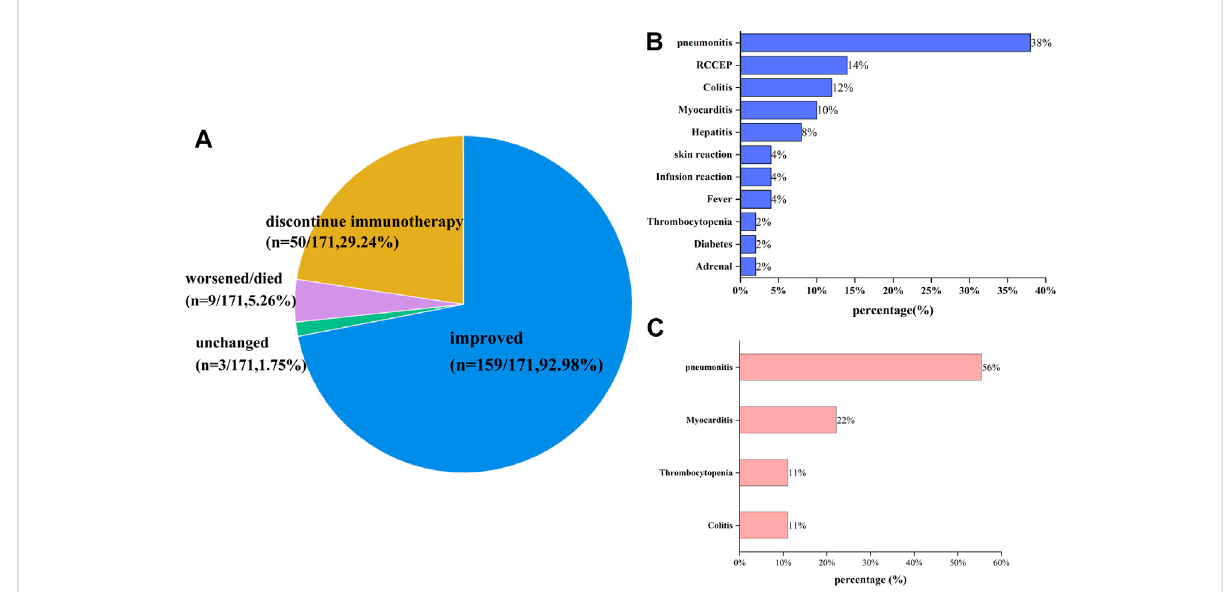
FIGURE 4 Outcomes ofpatients with irAEs: (A) theoutcomedistribution of patients with irAEs; (B) thereason for ending immunotherapy; (C) thecause of exacerbation or death for patients with irAEs. Overall, 92.98% of patients improved, and 1.75% of patients who experienced grade ≥ 3 RCCEP had unchanged. 5.26% of patients experienced worsened or died, with pneumonitis ( n = 5/9, 55.56%), myocarditis ( n = 2/9, 22.22%), colitis ( n = 1/9, 11.11%) and thrombocytopenia ( n = 1/9, 11.11%). 50 patients (29.24%) experienced discontinue immunotherapy for irAEs, with the common being pneumonitis ( n = 19/50, 38%), reactive capillary hemangiomas ( n = 7/50, 14%), colitis ( n = 6/12, 12%), myocarditis ( n =5/50, 10%), and hepatitis ( n = 4/50, 8%), and a few occurring in skin reaction ( n = 2), infusion reaction ( n = 2), fever ( n = 2), thrombocytopenia ( n = 1), diabetes ( n = 1), and adrenal ( n =